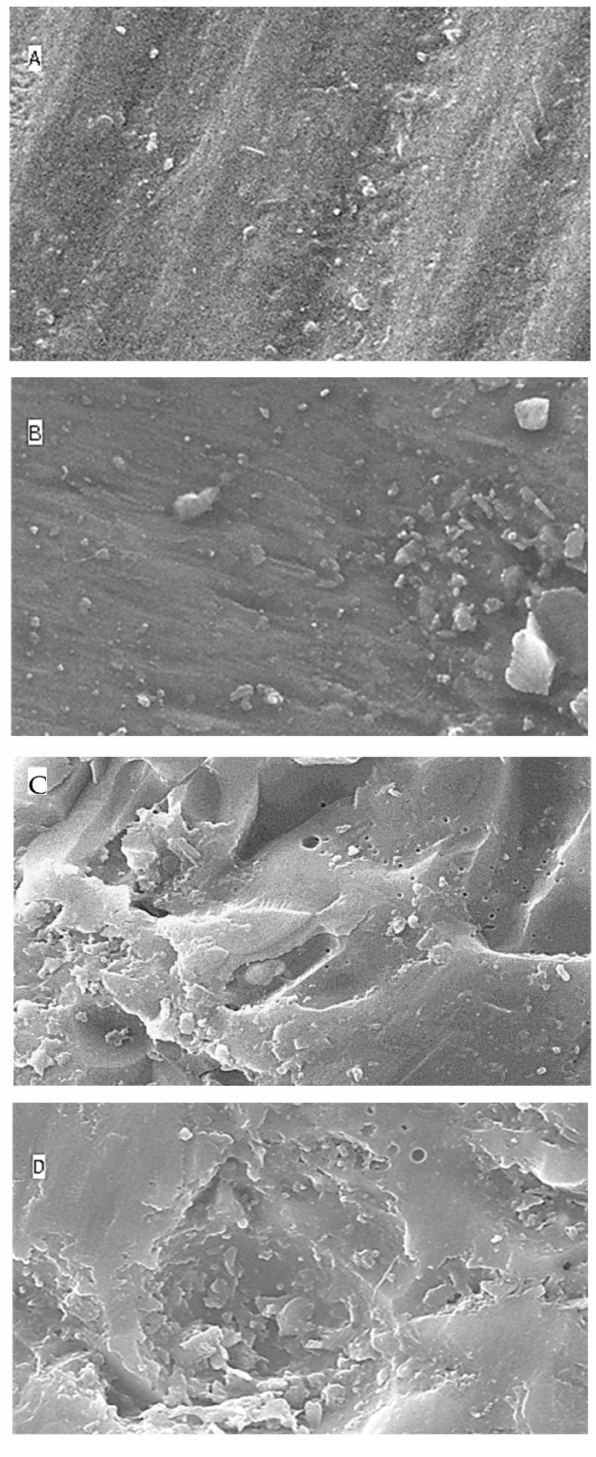
Figure 5. SEM images ( A – D ) of surface roughness at baseline, 24 h, 96 h and 168 h in lemon